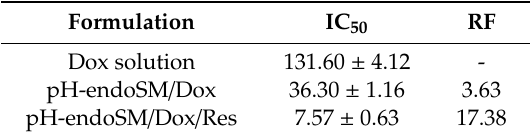
Table 2. The IC 50 and Resistance factor (RF) on the MCF-7 / ADR